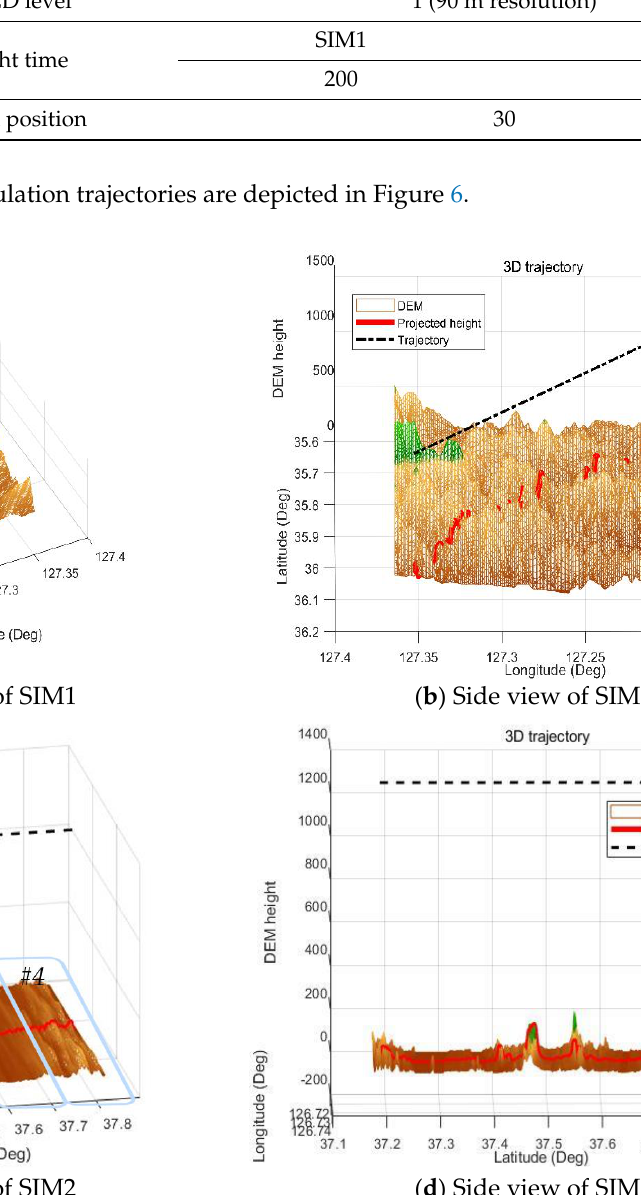
Figure 6. Simulation trajectories. ( a ) Orthographic projection of SIM1. ( b ) Side view of SIM1. ( c ) Orthographic projection of SIM2. ( d ) Side view of SIM2.